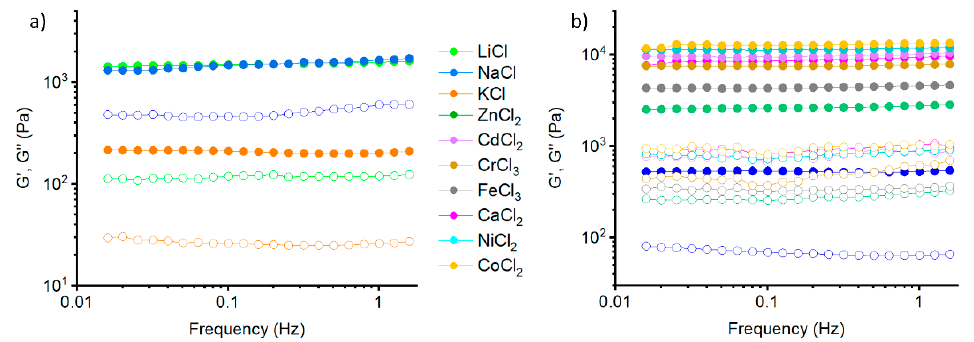
Figure 5. Frequency sweep experiments of metallogels triggered by ( a ) monovalent cations and ( b ) divalent and trivalent metal cations. G’ values are indicated with filled circles while G’’ values are indicated with open circles.